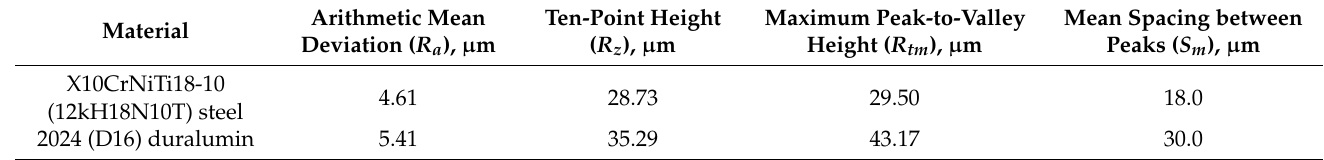
Figure 5. 3D profilograms of the samples after electrical discharge machining with a brass wire tool electrode in deionized water: ( a ) X10CrNiTi18-10 (12kH18N10T) steel, V o = 84 V, I = 2.0 A, D = 1.5 µs, f = 30 kHz, R w = 5.0 m/min, F t = 0.25 kg, R f = 0.1 mm/min; ( b ) 2024 (D16) duralumin, V o = 108 V, I = 0.8 A, D = 1.0 µs, f = 10 kHz, R w = 6.0 m/min, F t = 0.25 kg, R f = 0.1 mm/min. Table 6. Roughness of sample surfaces after electrical discharge machining.